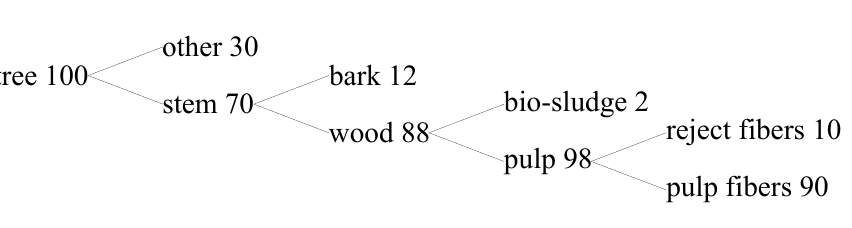
Figure 1. Available biomass residues in a TMP mill.